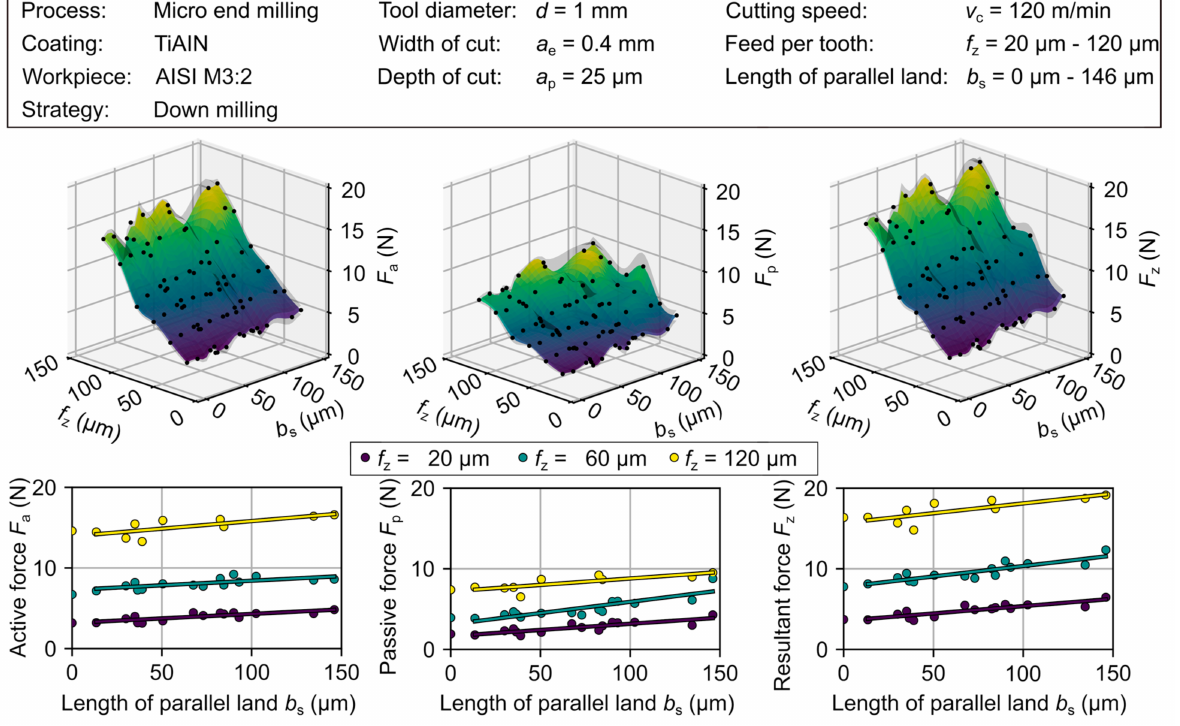
Figure 13. Resulting cutting forces subdivided according to passive and active force